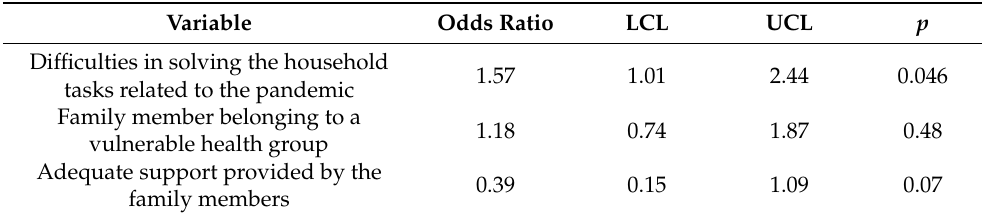
Table 4. Extra-professional burden during COVID-19